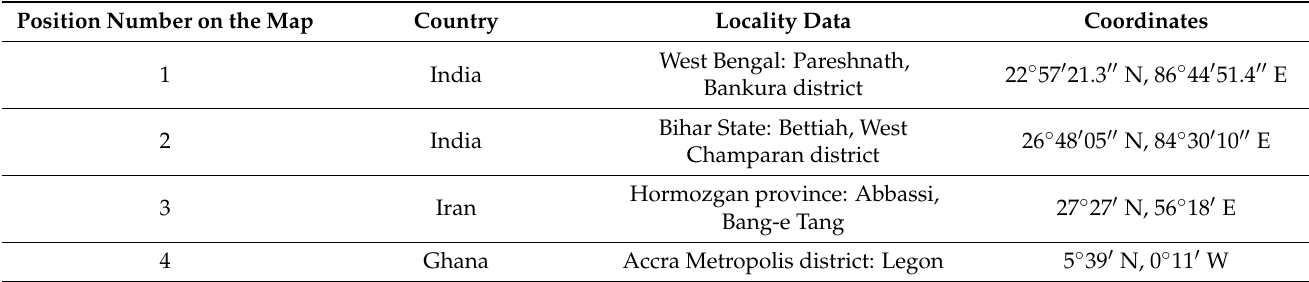
Table 1. Geographic coordinates for each locality where R . rex was